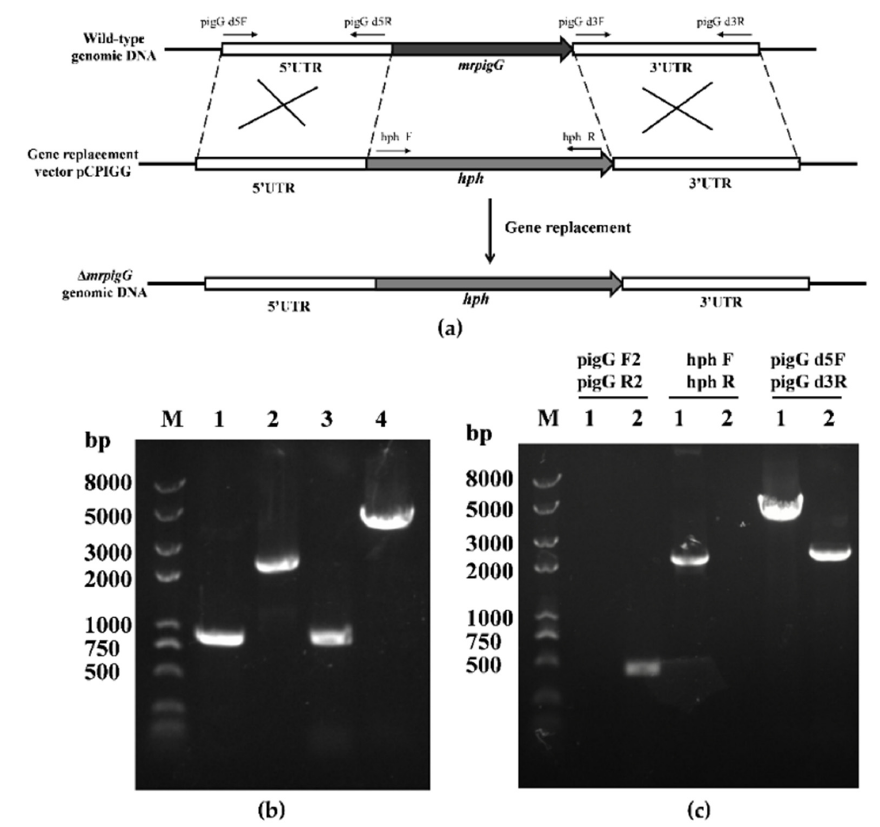
Figure 1. Deletion of mrpigG in M. ruber M7. ( a ) Schematic representation of the homologous recombination strategy yielding mrpigG deletion strains. ( b ) Construction of mrpigG disruption construct by double-joint PCR. Lane 1, 5 ′ flanking region of mrpigG ; lane 2, hygromycin resistance cassette; lane 3, 3 ′ flanking region of mrpigG ; lane 4, double-joint PCR product. ( c ) Confirmation of mrpigG homologous recombination events. Three primer pairs were used, and PCR amplifications showed distinct bands in different strains. Lane 1, the Δ mrpigG strain; lane 2, the wild-type strain. Three Δ mrpigG :: mrpigG strains with G418 resistance were obtained. PCR analysis of one of the Δ mrpigG :: mrpigG strains is shown in Figure 2c. A 0.5-kb product was amplified when the genomic DNA of Δ mrpigG :: mrpigG was used as template with primers pigG F2-pigG R2, whereas no DNA band was amplified using the genome of Δ mrpigG . A 1.22-kb fragment of the neo gene could be amplified from Δ mrpigG :: mrpigG using primers G418 F-G418 R, whereas nothing was obtained from Δ mrpigG . A 2.14-kb product of the hph gene could be amplified from Δ mrpigG using primers hphF- hphR, whereas nothing was obtained from Δ mrpigG :: mrpigG . The neo fragment replaced the hph gene, which might reveal that it was a successful homologous recombination event. Meanwhile, amplicons of Δ mrpigG :: mrpigG (3.9 kb) and Δ mrpigG (4.3 kb) differed in size when primers pigG d5F-pigG d3R, annealing to homologous arms, were used.